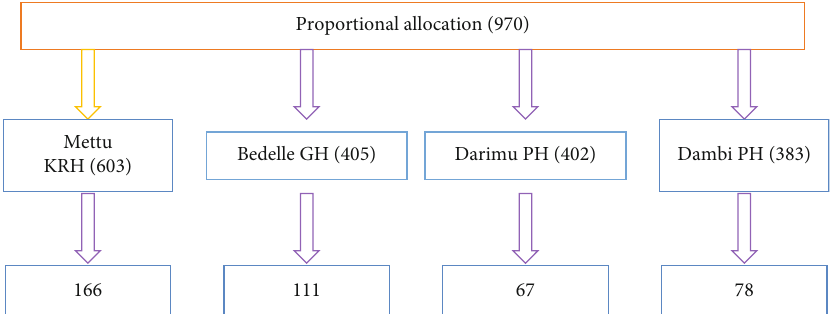
Figure 1: Proportional allocation of sample size for assessment of MetS and its associated factors among type 2 diabetics,